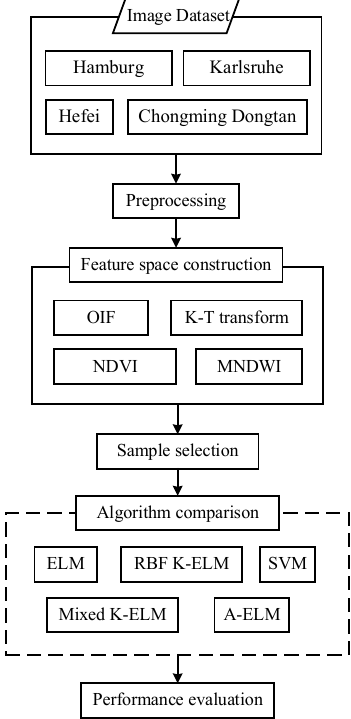
Figure 3 . Flowchart of comparison experiment